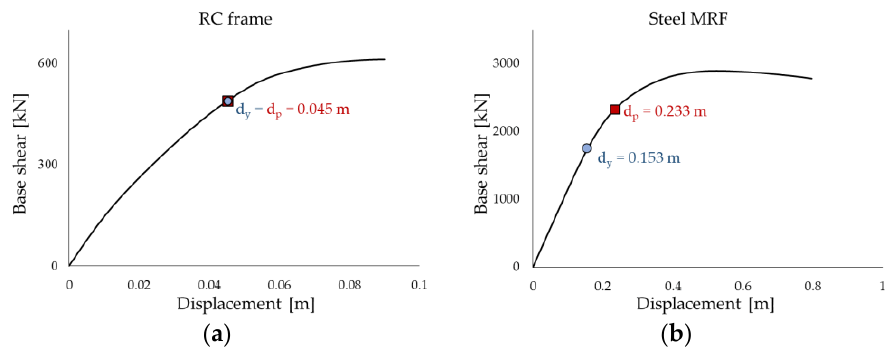
Figure 11. Capacity curves in the X-direction and limit values of displacements for the two case-study structures: ( a ) RC building, and ( b ) steel MRF building.